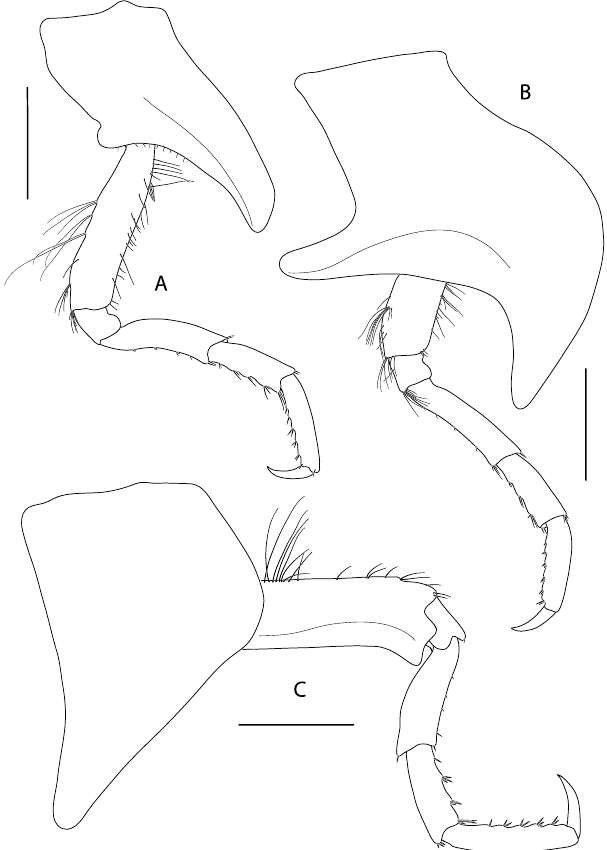
Figure 12. Epimeria frankei sp. nov., holotype, adult female, northern North Sea, NHMUK 2015.3264: ( A ) pereopod 3, ( B ) pereopod 4, ( C ) pereopod 5; all scales 1